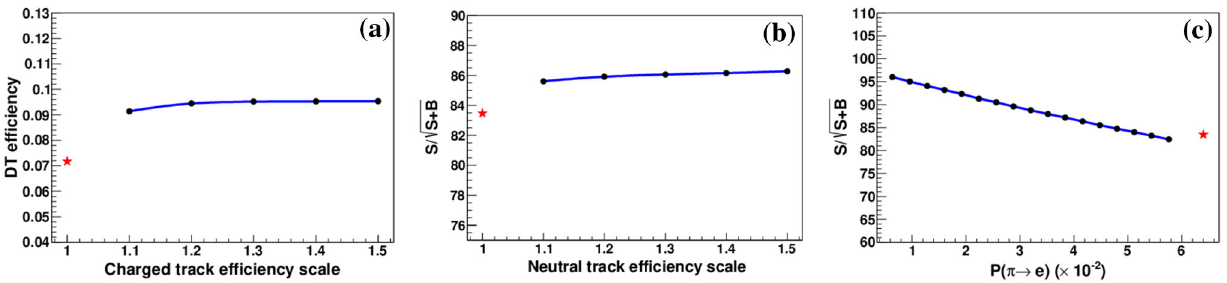
Fig. 6 The optimisation of DT efficiency for charged tracks of reconstructed efficiency ( a ); the optimisation of figure-of-merit for neutral tracks of reconstructed efficiency ( b ); the optimisation of figure-of-merit for misidentification from π + to e + ( c ). And the red star denotes the default